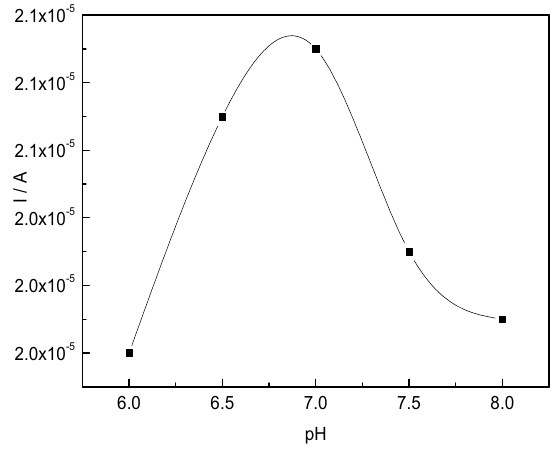
Figure 6. The effect of solution pH on the peak current.